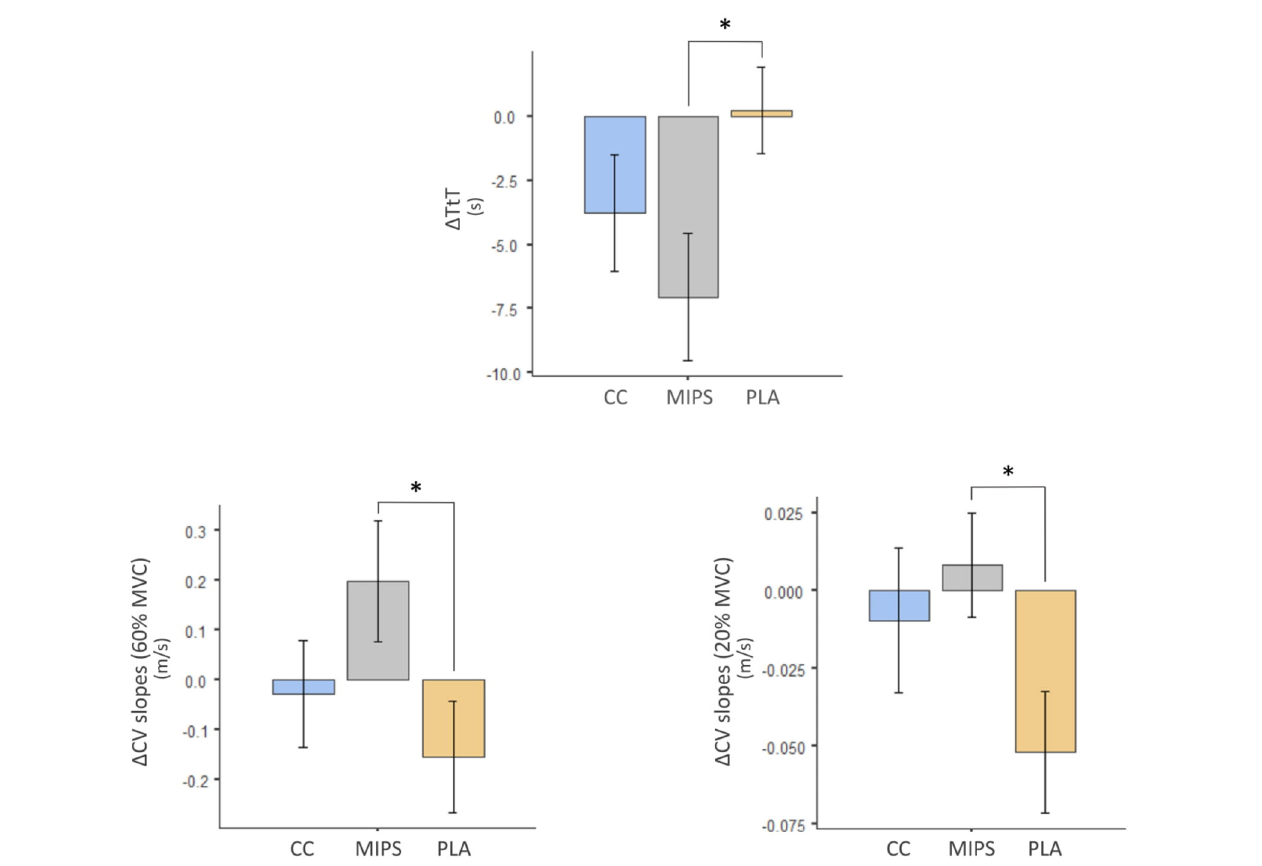
FIGURE 3 | ∗ Pre–post statistically significant mean differences for (cid:49) TtT, (cid:49) CV slopes (20% MVC), and for (cid:49) CV slopes (60% MVC) between MIPS and PLA. CV, conduction velocity (m/s); CV slopes (%/s); MVC, maximal voluntary contraction (kg); TtT, time to perform the task